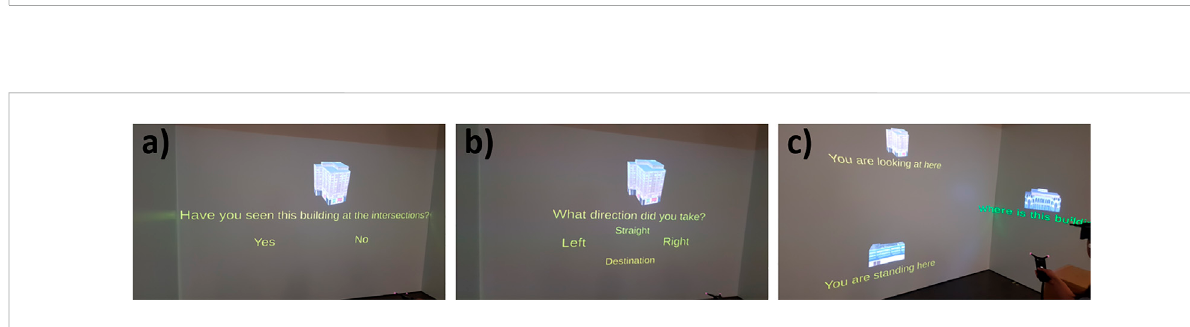
FIGURE 4 Spatiallearningtests:Panels (A) , (B) ,and (C) illustratehowaparticipantresponded inthelandmarkrecognitiontest,theroutedirectiontest,and the JRD test respectively. All tests were carried out in the CAVE using a 3D pointing